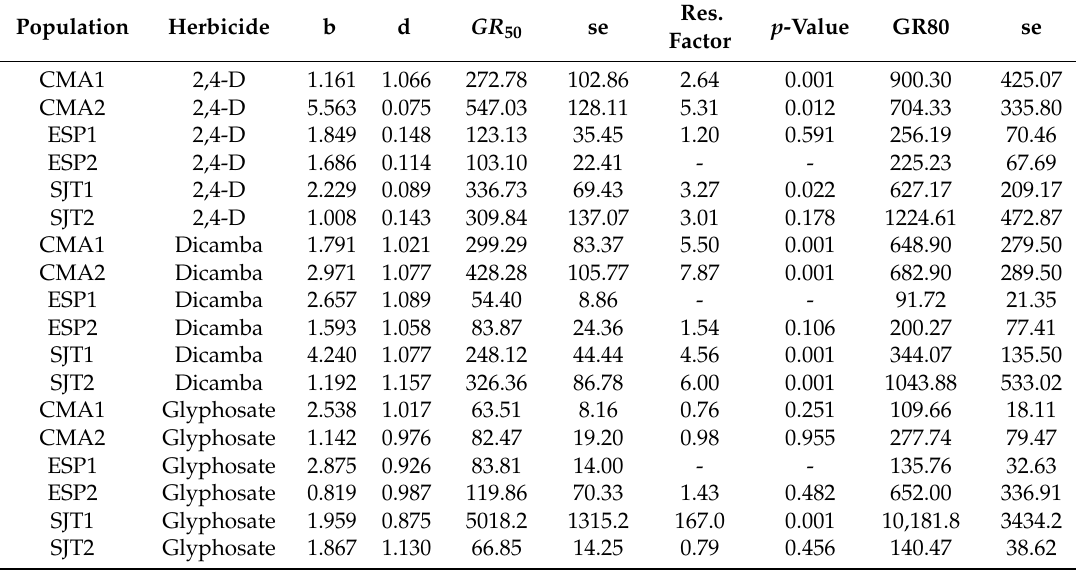
Table 1. Regression parameters of dose response based on fresh weight of six Amaranthus hybridus biotypes. Lack of Fit test indicated that the regression accurately described the data ( p = 0.58 for 2,4-D, p = 0.87 for dicamba and p = 0.99 for glyphosate).